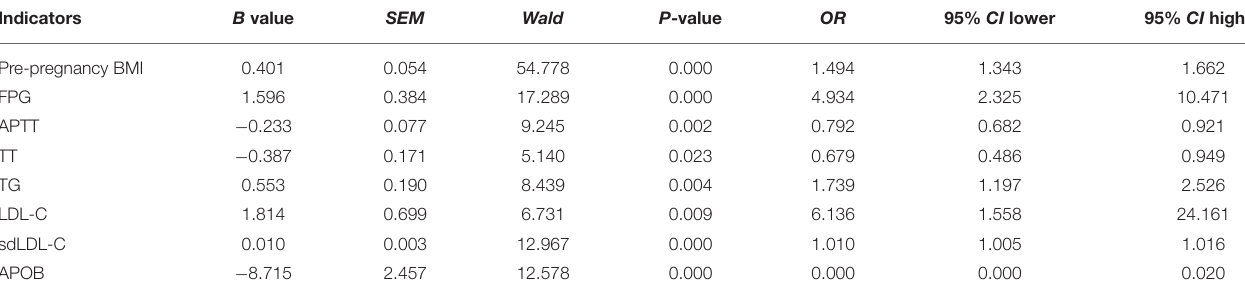
TABLE 4 | Multivariate logistic regression analysis results of predictors of